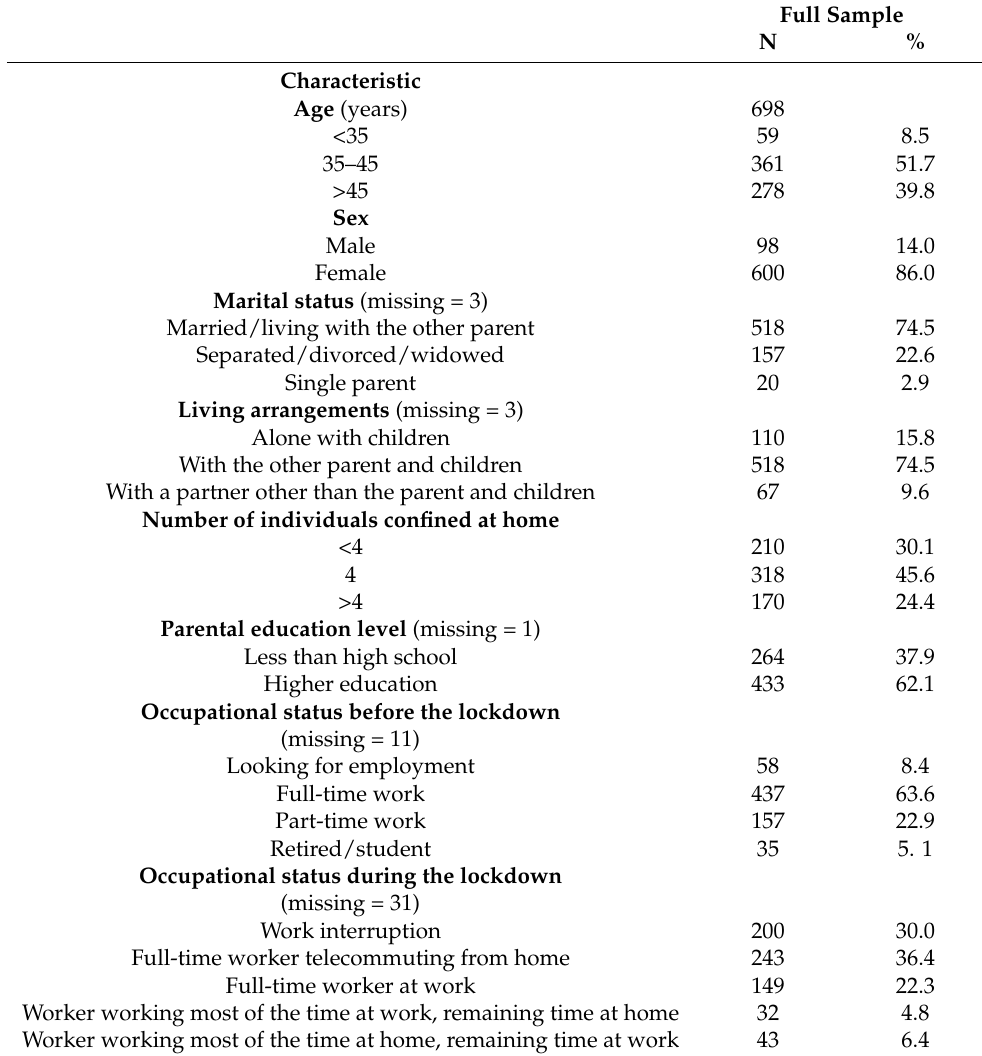
Table 1. Sociodemographic and working characteristics of the sample population of parents during the lockdown (N =